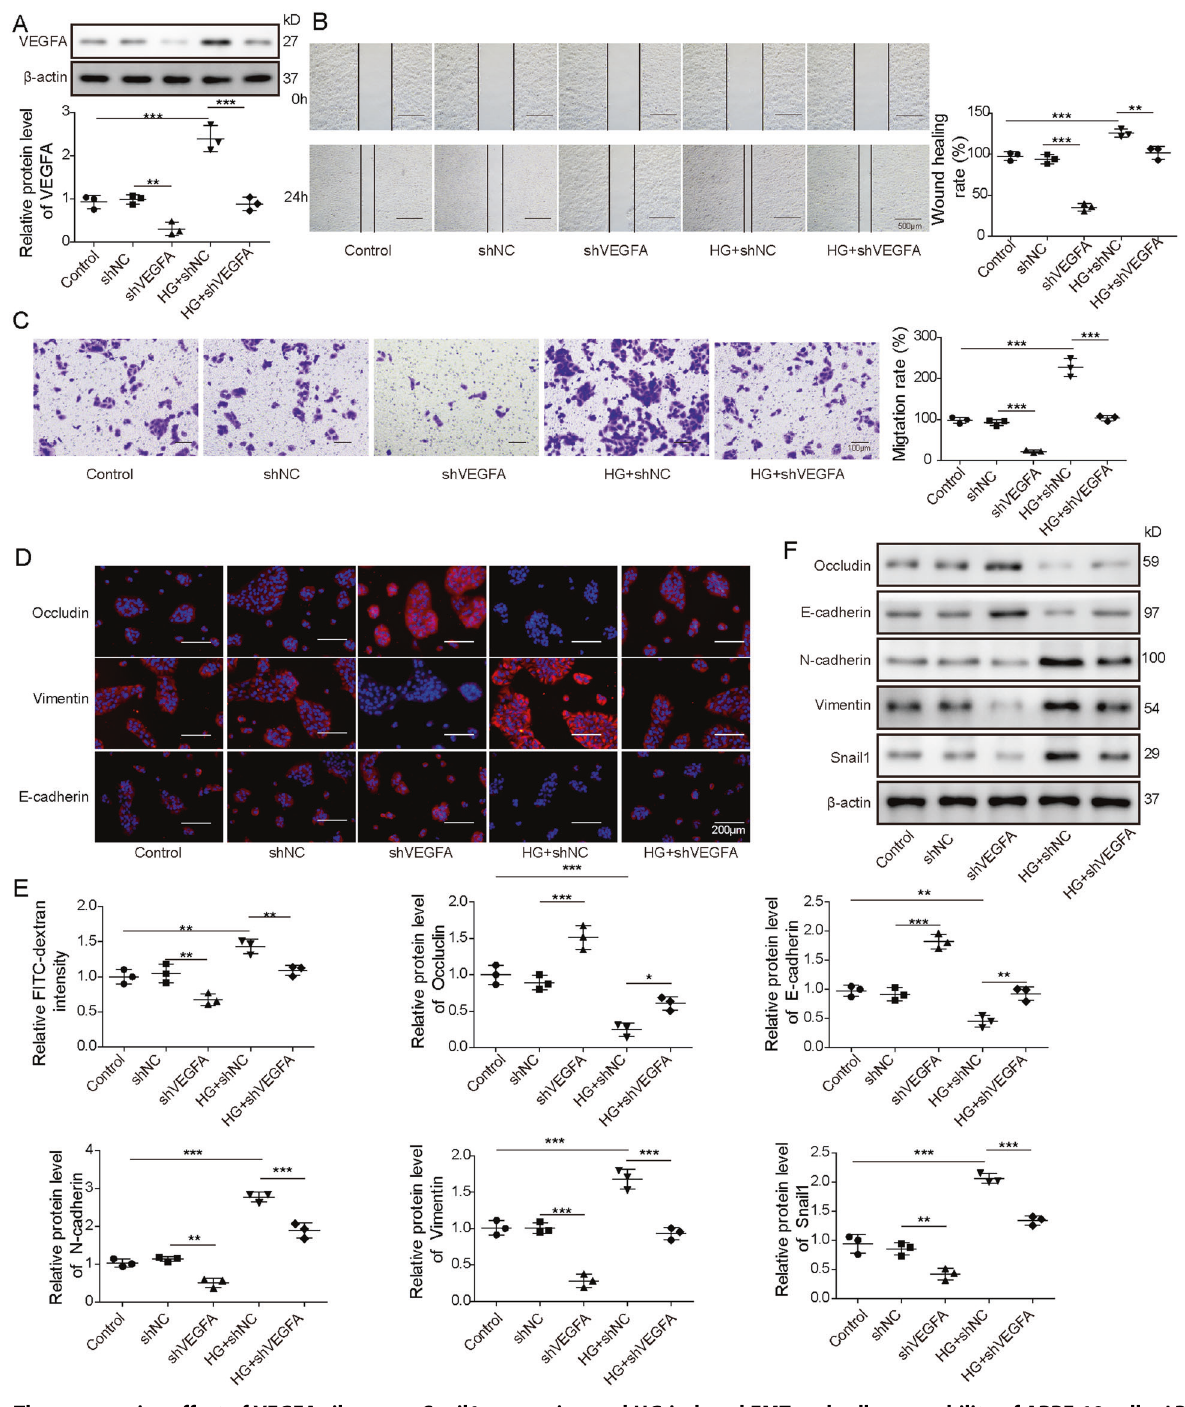
Fig. 2 The suppressive effect of VEGFA silence on Snail1 expression and HG-induced EMT and cell permeability of ARPE-19 cells. ARPE-19 cells were transfected with shNC or shVEGFA and were then stimulated or not stimulated by HG. A VEGFA expression was measured by western blotting in the treated cells. B , C The migratory ability was detected via wound-healing analysis and transwell assay in the treated cells. D Occludin, E-cadherin, and Vimentin levels were examined by immuno fl uorescence in the treated cells. E Cell permeability was measured via FITC-dextran assay in the treated cells. F Snail1, Occludin, E-cadherin, N-cadherin, and Vimentin levels were detected via western blotting in the treated cells. For each analysis, three technical replicates were performed and three biological independently performed replicates are included, * p < 0.05, ** p < 0.01, *** p < Mut-VEGFA luciferase reporter vectors were constructed. The dual- predicted there were binding sites of YY1 on the promoter of luciferase reporter assay showed YY1 overexpression increased VEGFA and Snail1. Further, ChIP assay showed that YY1 could bind the luciferase activity of WT-Snail1 or WT-VEGFA, but it did not with the promoter of VEGFA and Snail1 to initiate their expression affect the activity of Mut-Snail1 or Mut-VEGFA (Fig. 4C). In (Fig. 4B). In addition, the WT-Snail1, Mut-Snail1, WT-VEGFA, and